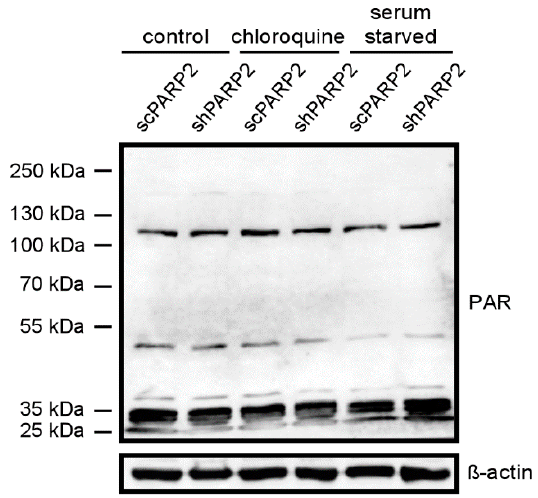
Figure 10. The silencing of PARP2 modulates cellular PARylation under chloroquine treatment and fasting. scPARP2 and shPARP2 cells were treated with chloroquine (25 µM 2 h) or were fasted for 12 h. Then cells were lysed and lysates were separated by PAGE and were subjected to Western blotting using anti-PAR antibody. Experiments were repeated three times; a representative blot is shown.